Question: Condense the content of this figure into a single sentence.
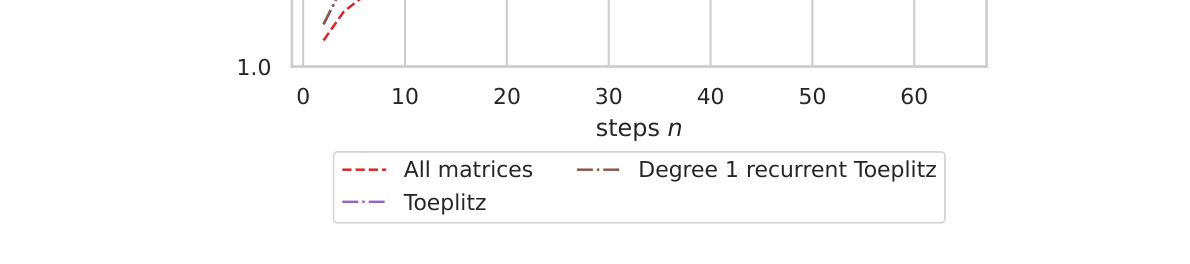
Answer: Semidefinite programming based lower bounds on optimal performance for various classes of matrices based on the results from theorem 7.1